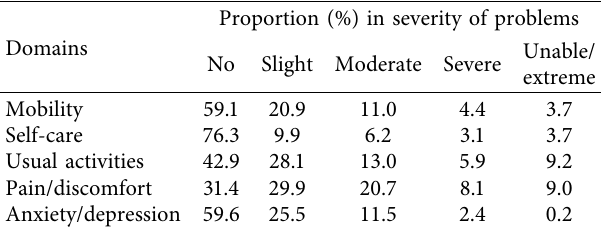
Table 5: Patients’ proportion in each domain of Europe Quality of Life 5 Dimensions 5 Level (EQ-5D-5L).